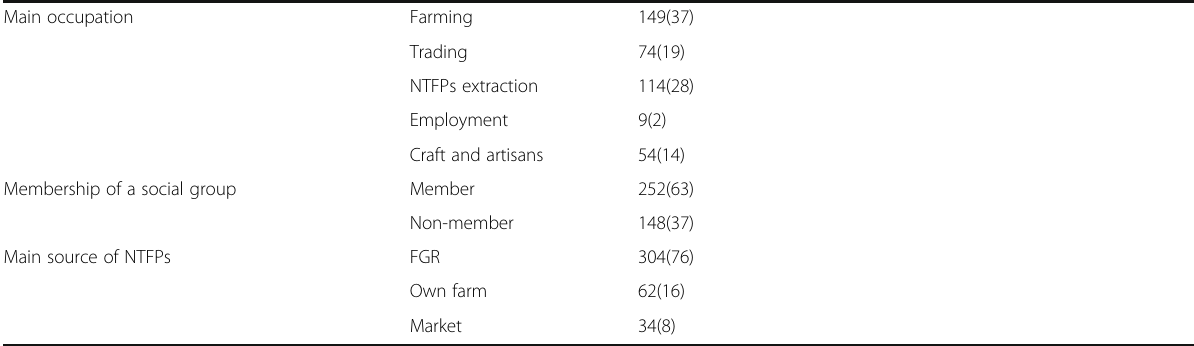
Table 2 Socioeconomic attributes of the respondents (Continued)